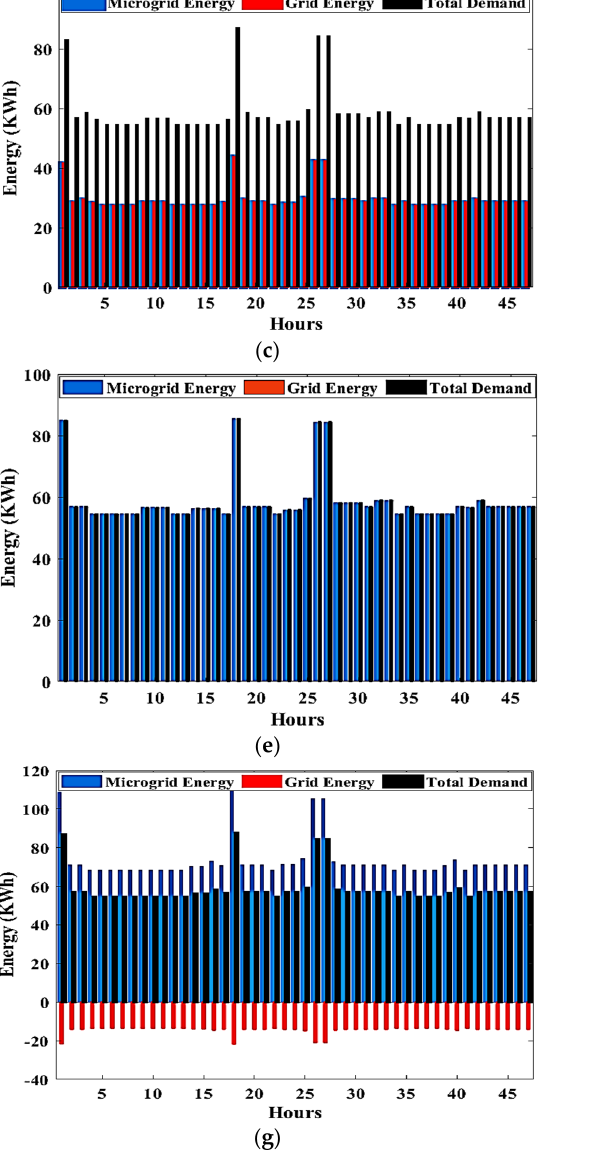
Figure 8. The amount of power generated by the MG and the grid, the amount of power consumed by loads, and the grid costs with the MG supply power set to 0 ( a , b ), 0.5 ( c , d ), 1 ( e , f ), and 1.25 ( g , h ) from the total power consumed.